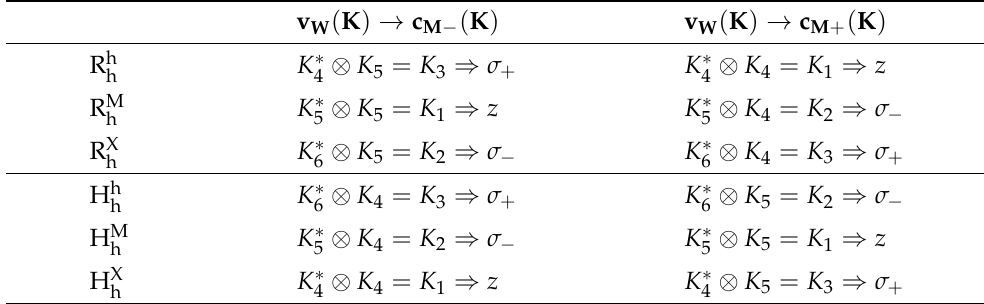
Table 5. Symmetry-based selection rules for the direct interlayer excitons at the K point in the C 3 symmetry